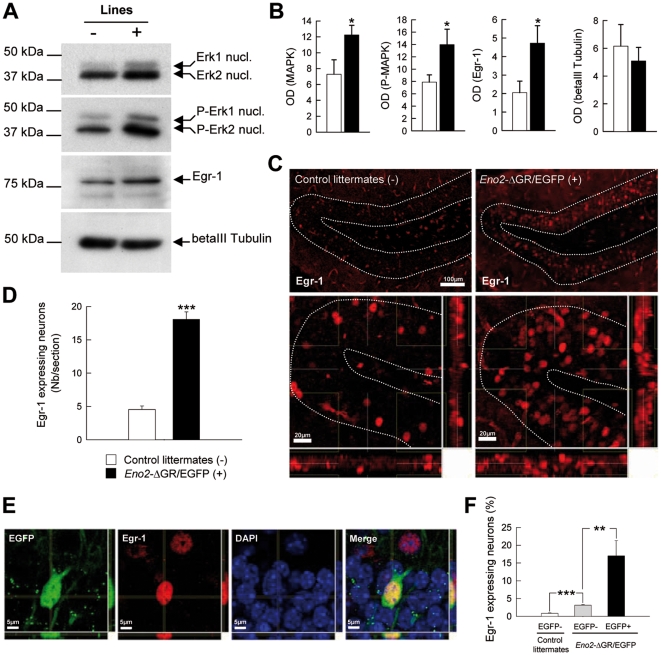
Stimulation of the MAPK pathway and Egr-1 by ΔGR in Eno2-ΔGR/EGFP bigenic mice.(A) Nuclear non-phosphorylated, phosphorylated Erk1/2 and Egr-1 proteins from hippocampi of Eno2-ΔGR/EGFP bigenic mice (+) (n = 9) and control littermates (−) (n = 9) were analyzed by western blot. BetaIII-tubulin was used as a loading control. (B) The corresponding X-Ray films were quantified by densitometry (optical density, OD, means +/− sem) and showed a higher expression of the proteins studied in Eno2-ΔGR/EGFP bigenic mice. (C) Confocal illustration of neurons expressing Egr-1 within the dentate gyrus of Eno2-ΔGR/EGFP bigenic mice and control littermates. (D) Number of Egr-1 expressing neurons in the dentate gyrus of Eno2-ΔGR/EGFP bigenic mice (black, n = 4) and control littermates (white, n = 4). (E) Confocal illustration of neurons co-expressing EGFP (green) and Egr-1 (red) in the dentate gyrus of Eno2-ΔGR/EGFP bigenic mice; the cells were counterstained with DAPI (blue). (F) Percentage of Egr-1 expressing neurons within the different subpopulation of cells in the dentate gyrus of Eno2-ΔGR/EGFP bigenic mice and control littermates. Values shown are means +/− sem. * = P<0.05, ** = P<0.01, *** = P<0.001.